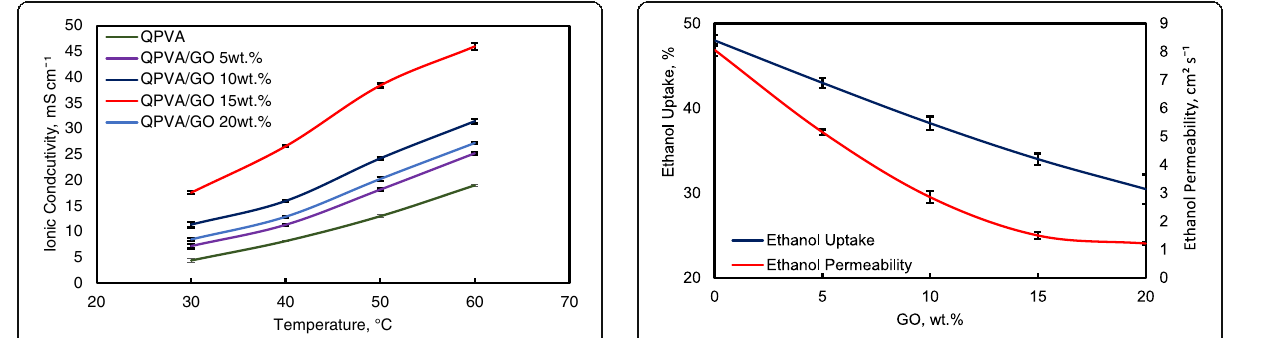
Fig. 11 Ionic conductivity analysis of QPVA membrane and QPVA/ GO composite membrane at different temperature